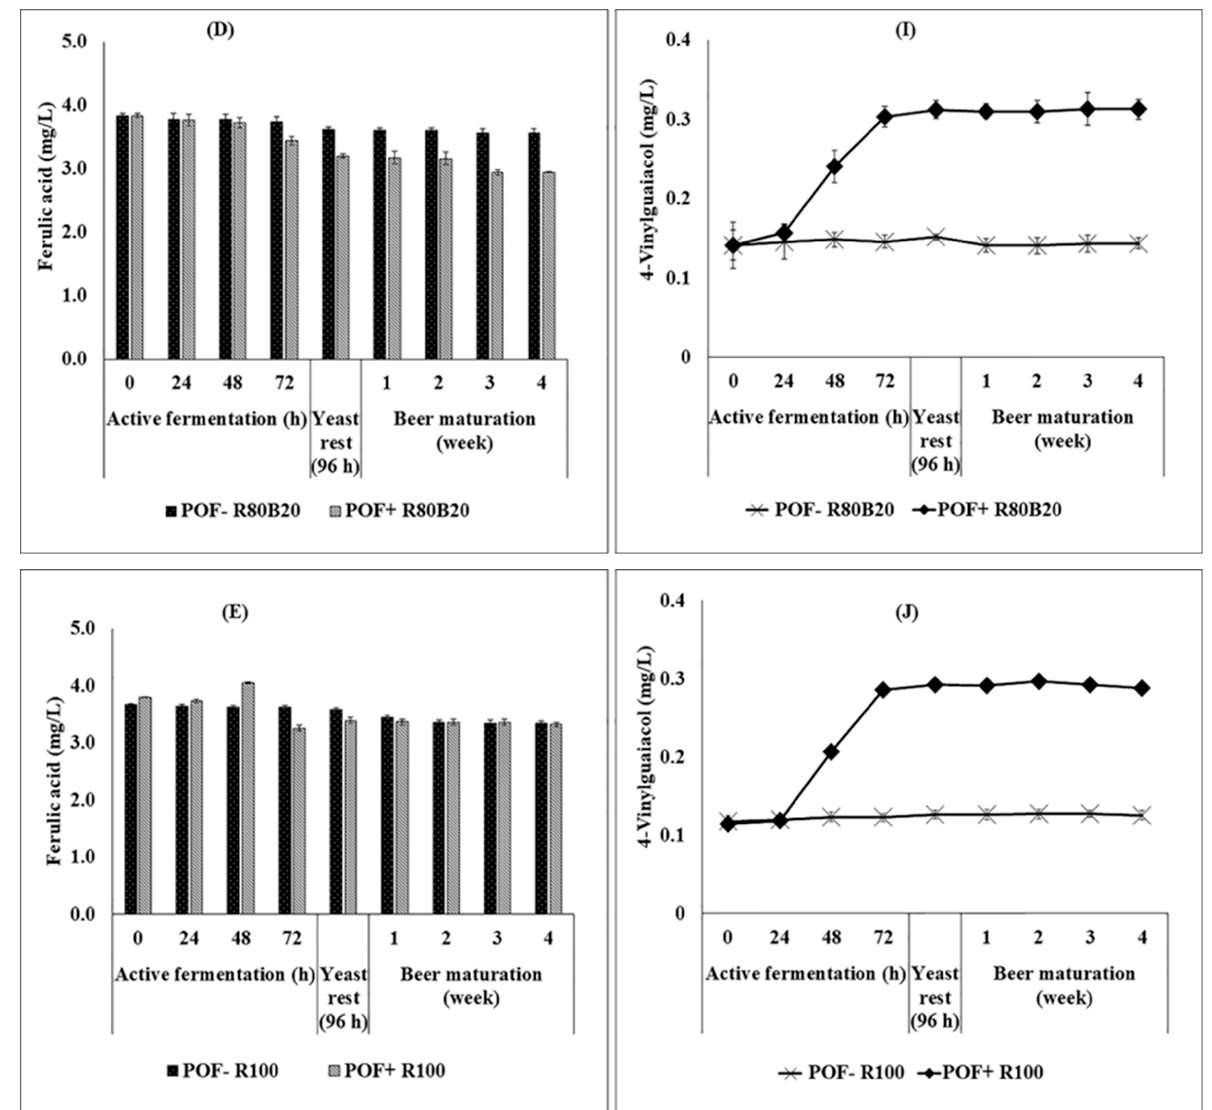
Figure 2. Ferulic acid and 4-vinylguaiacol concentration in the fermented composite wort (B100, R40B60, R60B40, R80B20, and R100) by two yeast strains BRY 97 ( S. cerevisiae ), POF − ( A – E ); and Belle R40B60, R60B40, R80B20, and R100) by two yeast strains BRY 97 ( S . cerevisiae ), POF − ( A – E ); and